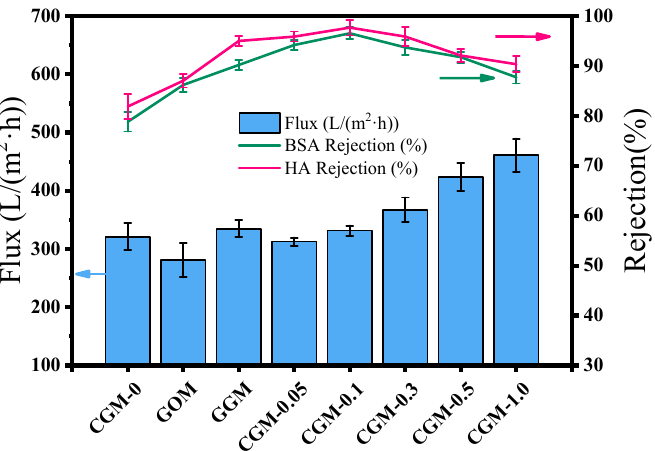
Figure 9. Pure water flux, BSA rejection and HA rejection of different membranes.